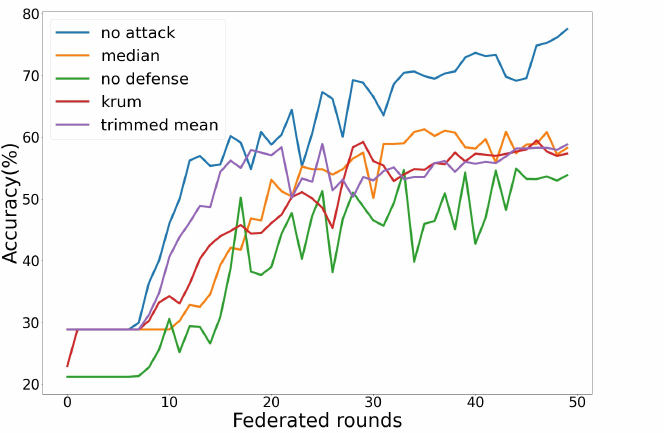
Figure 6. Accuracy for the model degradation attack with various defense